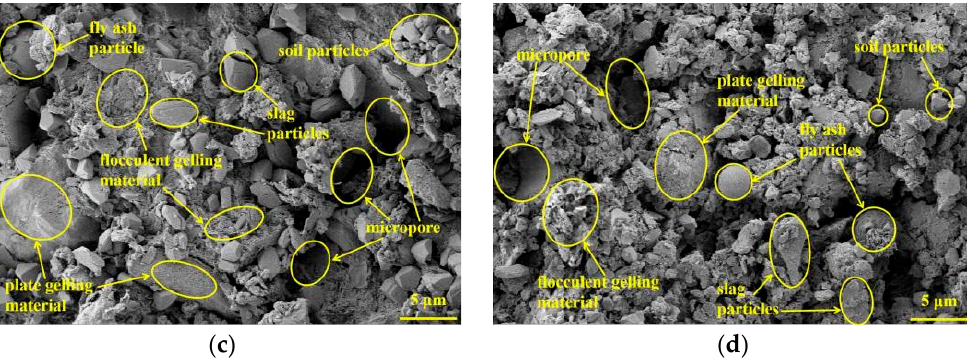
Figure 10. SEM analysis of SF-GSSS before sulfate attack: ( a ) S10F0; ( b ) S9F1; ( c ) S8F2; and ( d ) S7F3.